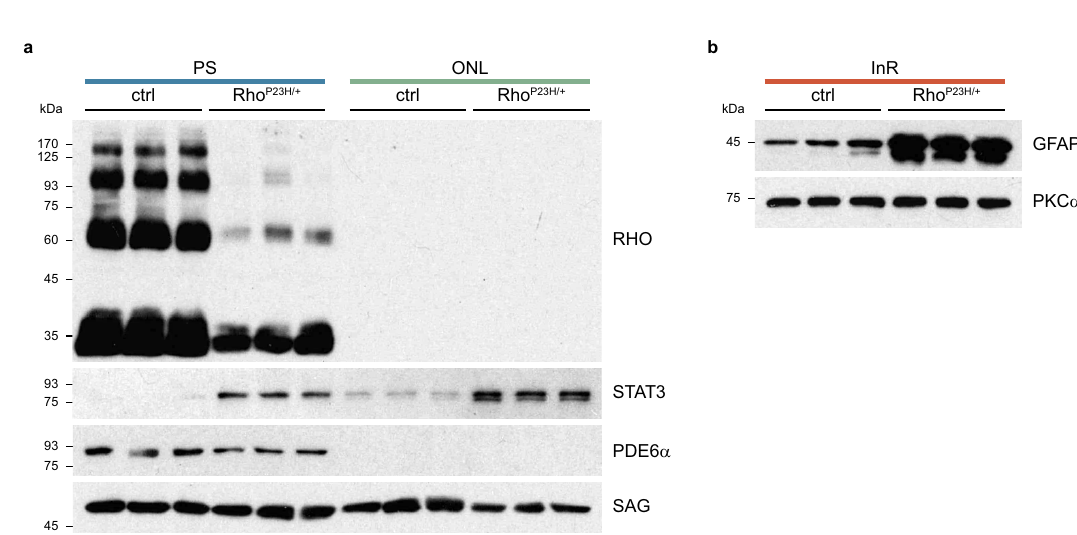
Figure 4. Photoreceptor degeneration and reactive gliosis in the retina of heterozygous P23H knock-in mice. ( a ) The levels of rhodopsin (RHO) and STAT3 were analysed in the PS and ONL of control and 3 months old Rho P23H/+ mice. PDE6 α located exclusively in PS samples was used as a control for layer separation and SAG as a loading control. ( b ) The levels of GFAP were analysed in the InR of control and 3 months old Rho P23H/+ mice. PKC α was used as a loading control. n =